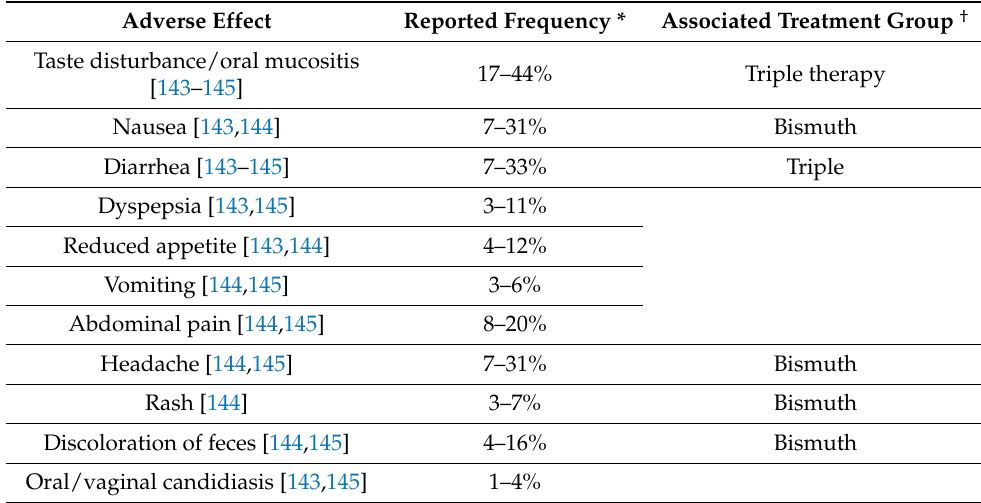
Table 3. Medication adverse events resulting from H. pylori